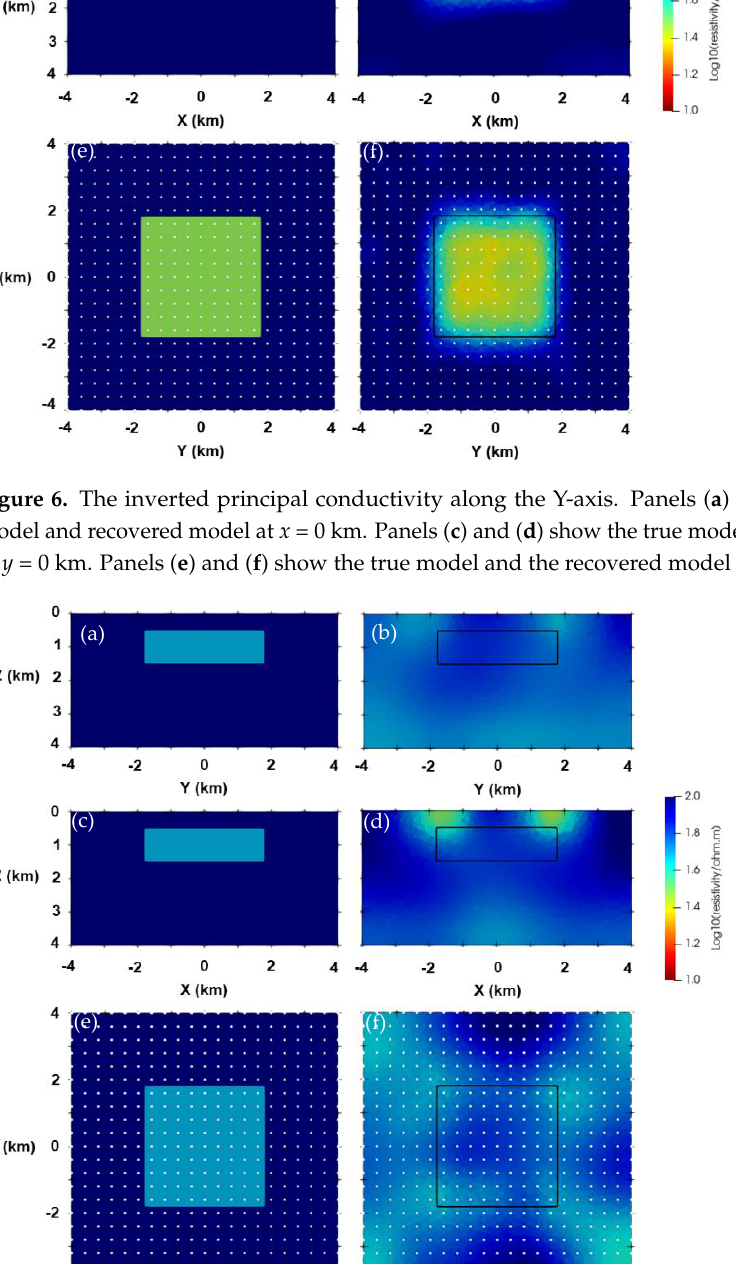
Figure 7. The inverted principal conductivity along Z-axis. Panels ( a ) and ( b ) show the true model and the recovered model at x = 0 km. Panels ( c ) and ( d ) show the true model and the recovered model at y = 0 km. Panels ( e ) and ( f ) show the true model and the recovered model at z = 1 km.